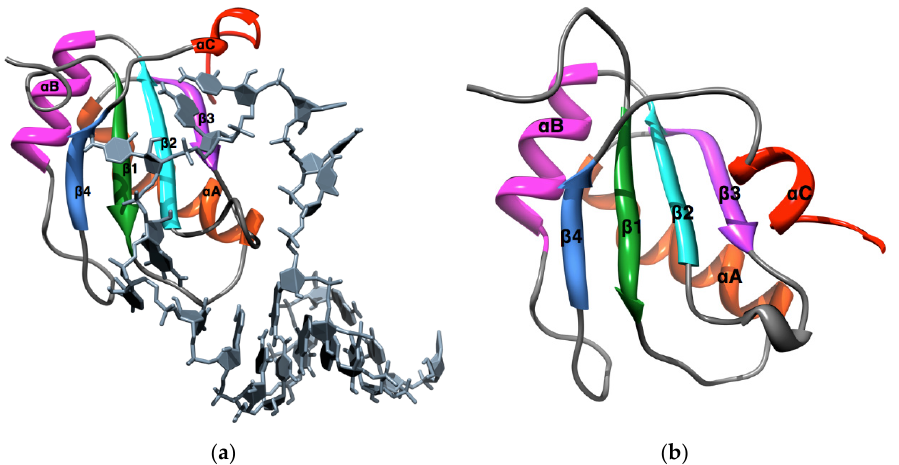
Figure 1. ( a ) Crystal Structure of the protein U1A-Stem loop 2 RNA Complex [24], with secondary structure and other elements annotated; ( b ) NMR solution structure of uncomplexed U1A [23], structure #5 from the ensemble of pdb